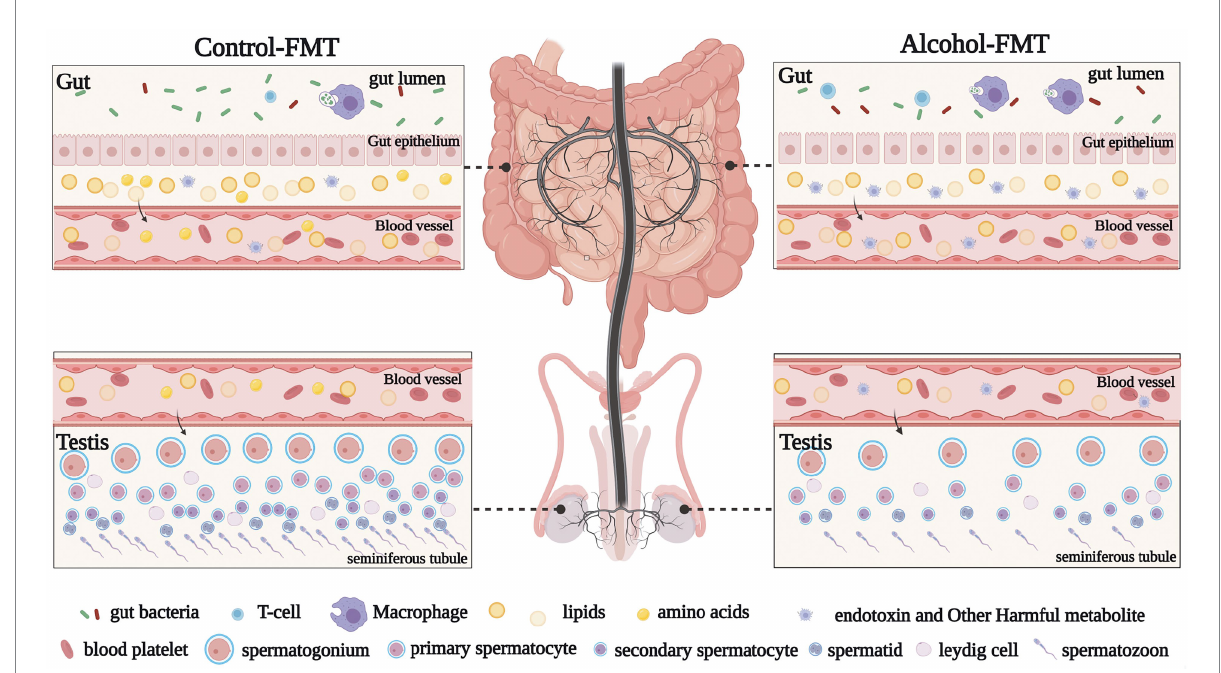
FIGURE 7 Graphical abstract. Diagram illustrating that alcohol affects sperm quality via the gut microbiota-gut-testis axis. Notably, the effect of chronic drinking on the sperm of male mice can be transferred to the testes of new male mice via gut microbiota exposed to chronic drinking, which leads to abnormal sperm quality in the alcohol-FMT